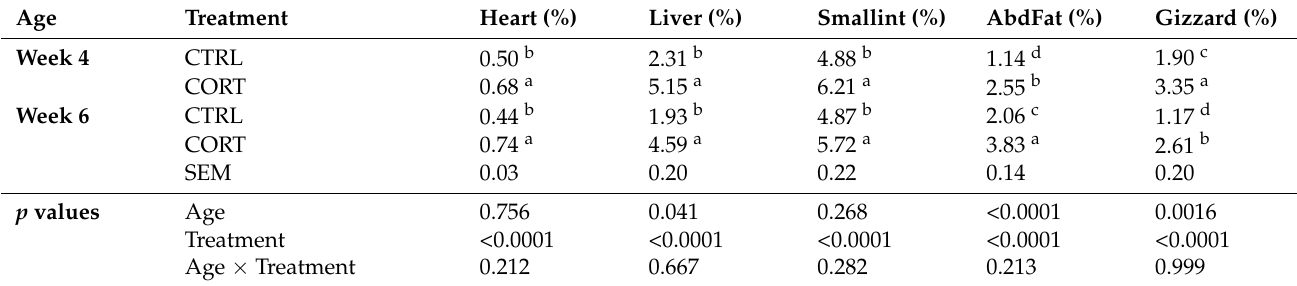
Table 5. Effect of corticosterone feeding and age on relative organ weights.